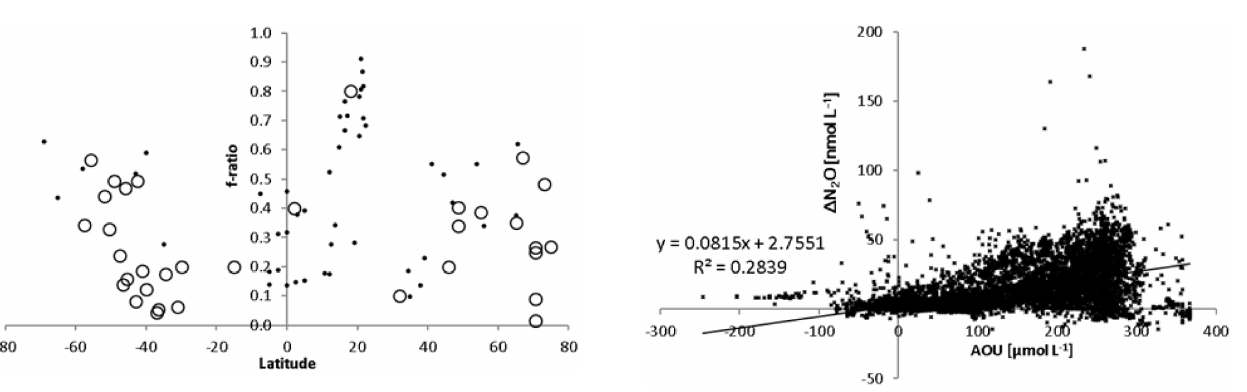
+ ρ + ρ urea )) as a function of /(ρ Figure 2. f ratio ( ρ NO − 3 NO − 3 NH + 4 Figure 3. Apparent N 2 O production ( (cid:49) N 2 OnmolL − 1 ) as a func- latitude, from 15 N uptake experiments. Small dots were estimated tion of apparent oxygen utilisation (AOUµmolL − 1 ). without measuring NH + or urea concentrations (Prakash et al., 4 2008, 2015; Gandhi et al., 2010, 2012). Large dots did not give a significant linear relationship with absolute value of latitude and were therefore averaged at 0.29 ± 0.18 (Wafar et al., 2004; Varela et al., 2005, 2013; Joubert et al., 2011; Thomalla et al., 2011; Simp- son et al., 2013).